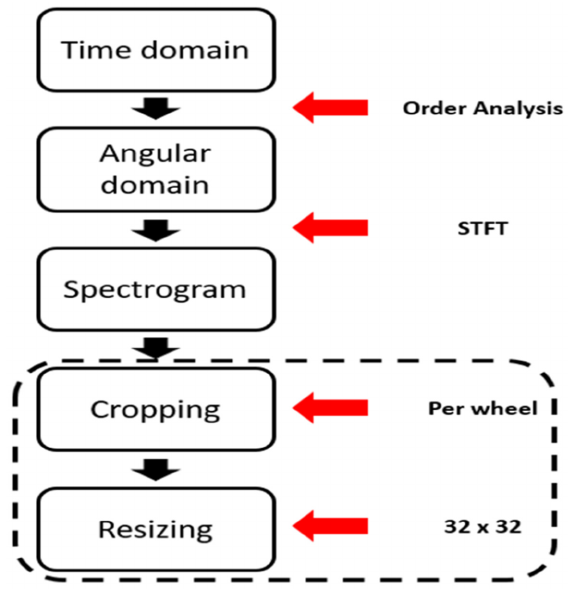
Figure 28. Pre-process diagram using a signal processing method.